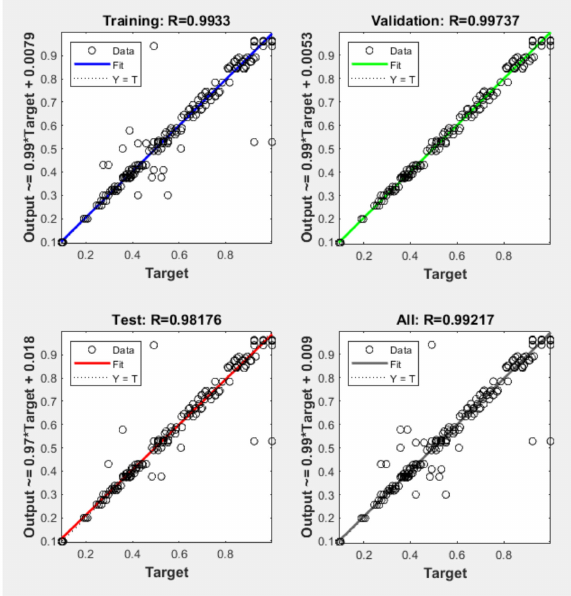
Figure 3. The ANN goodness of